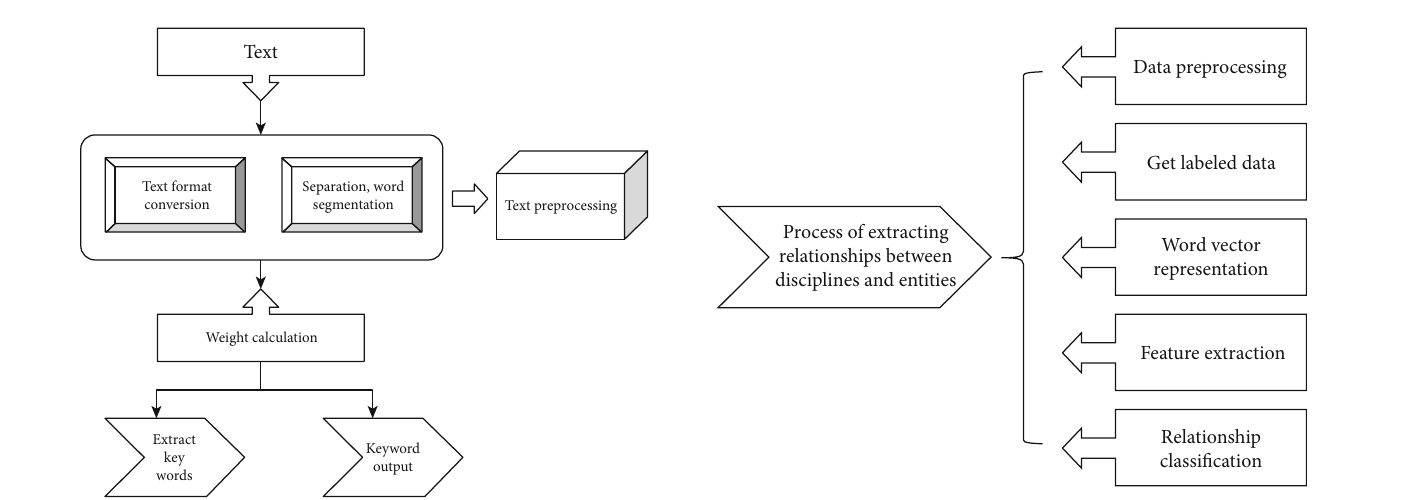
Figure 2: Keyword extraction process.